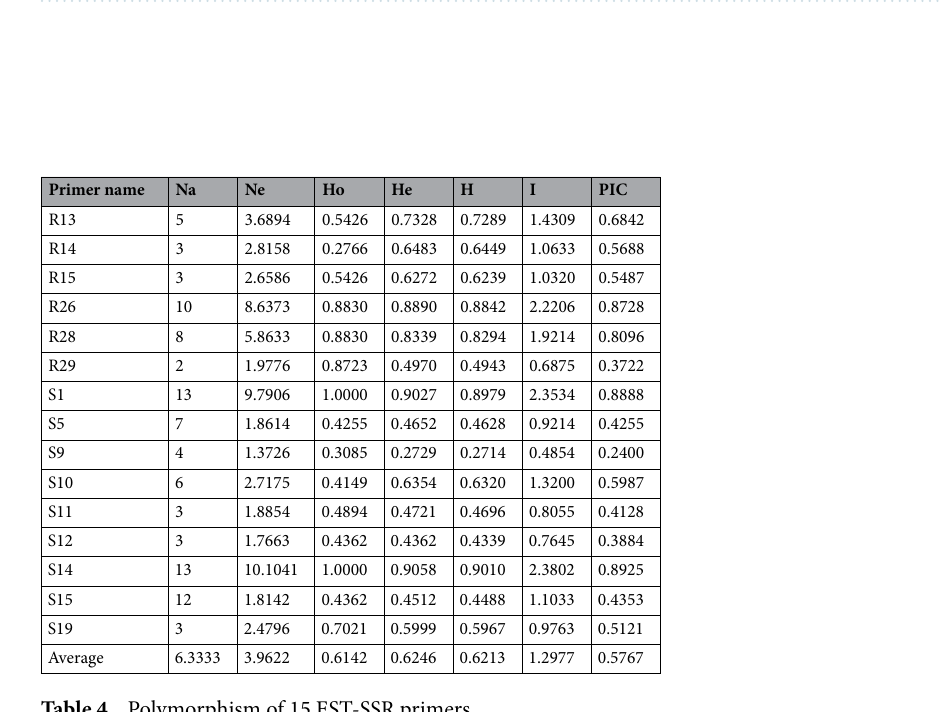
Table 4. Polymorphism of 15 EST-SSR